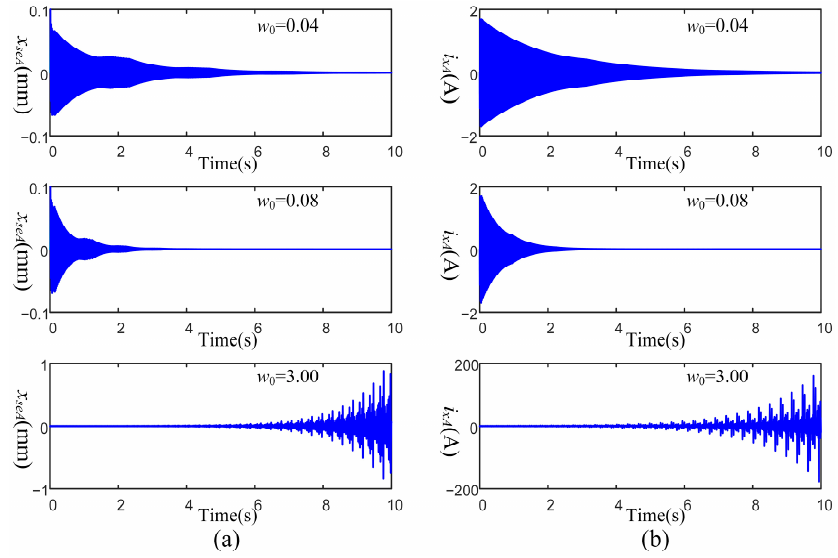
Figure 8. Simulation results of the NAC algorithm: ( a ) Displacement vibration elimination with different initial iteration factors; ( b ) Current vibration elimination with different initial iteration factors.